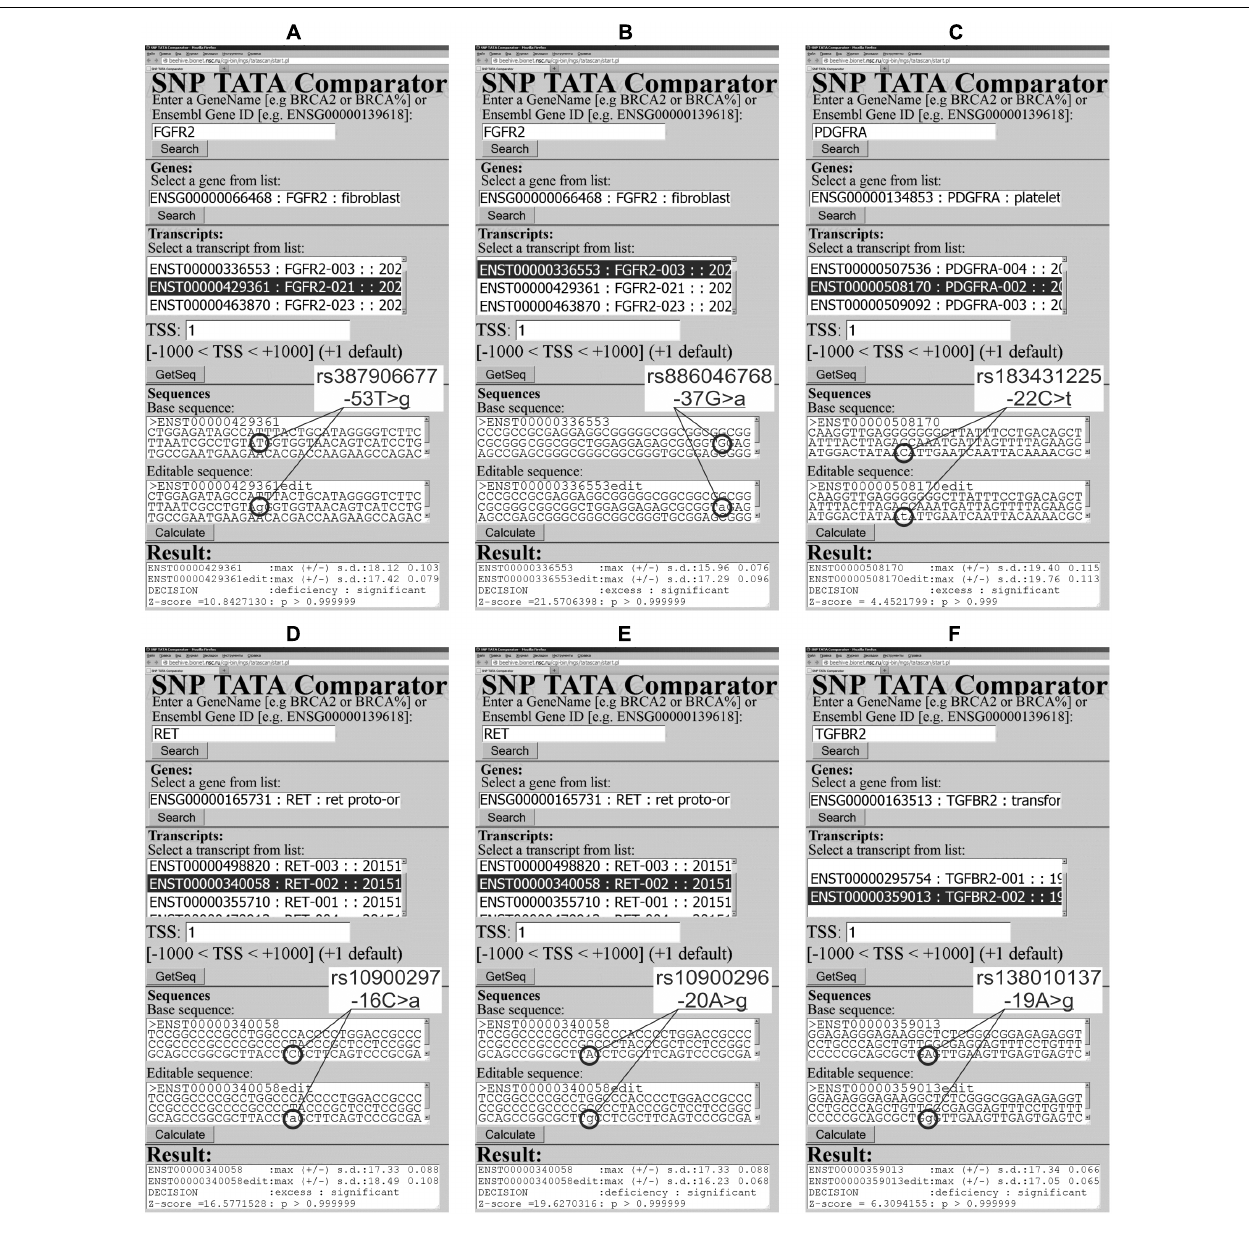
FIGURE 3 | Examples of our predictions in this work in the case of human genes encoding neurotrophinergic-system-related proteins. (A) rs387906677; (B) rs886046768; (C) rs183431225; (D) rs10900297; (E) rs10900296; and (F) rs138010137.